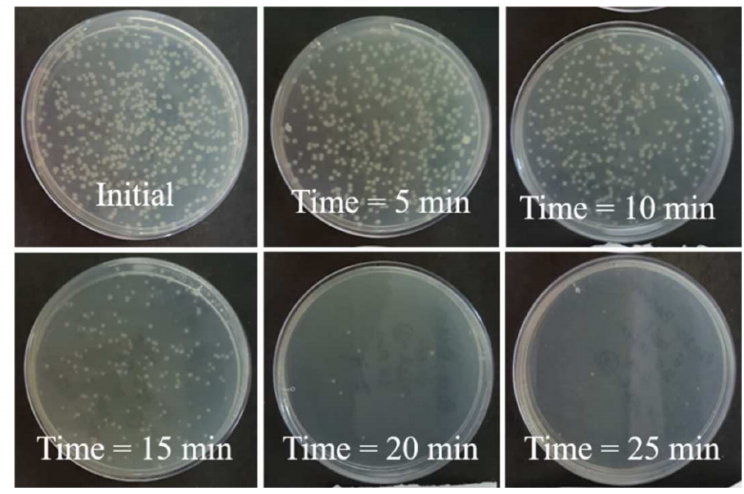
Figure 9. Agar plates showing the bacterial concentration for different periods of treatment.